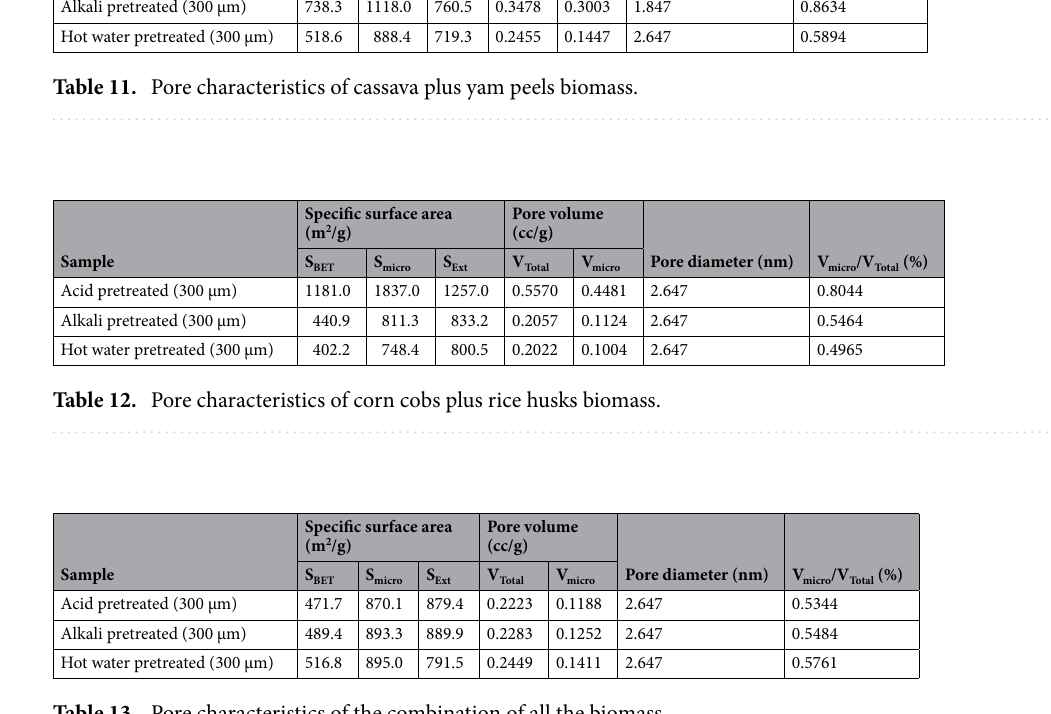
Table 13. Pore characteristics of the combination of all the